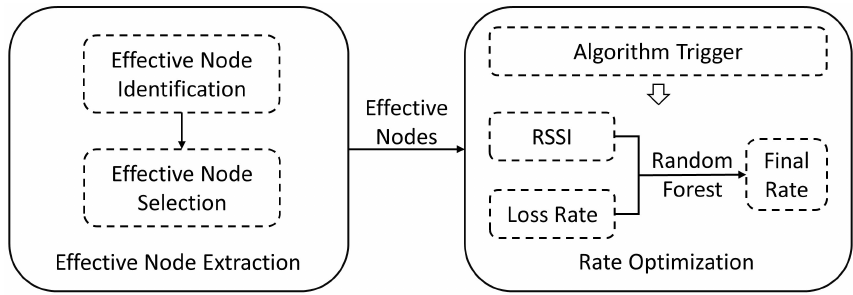
Figure 1. System